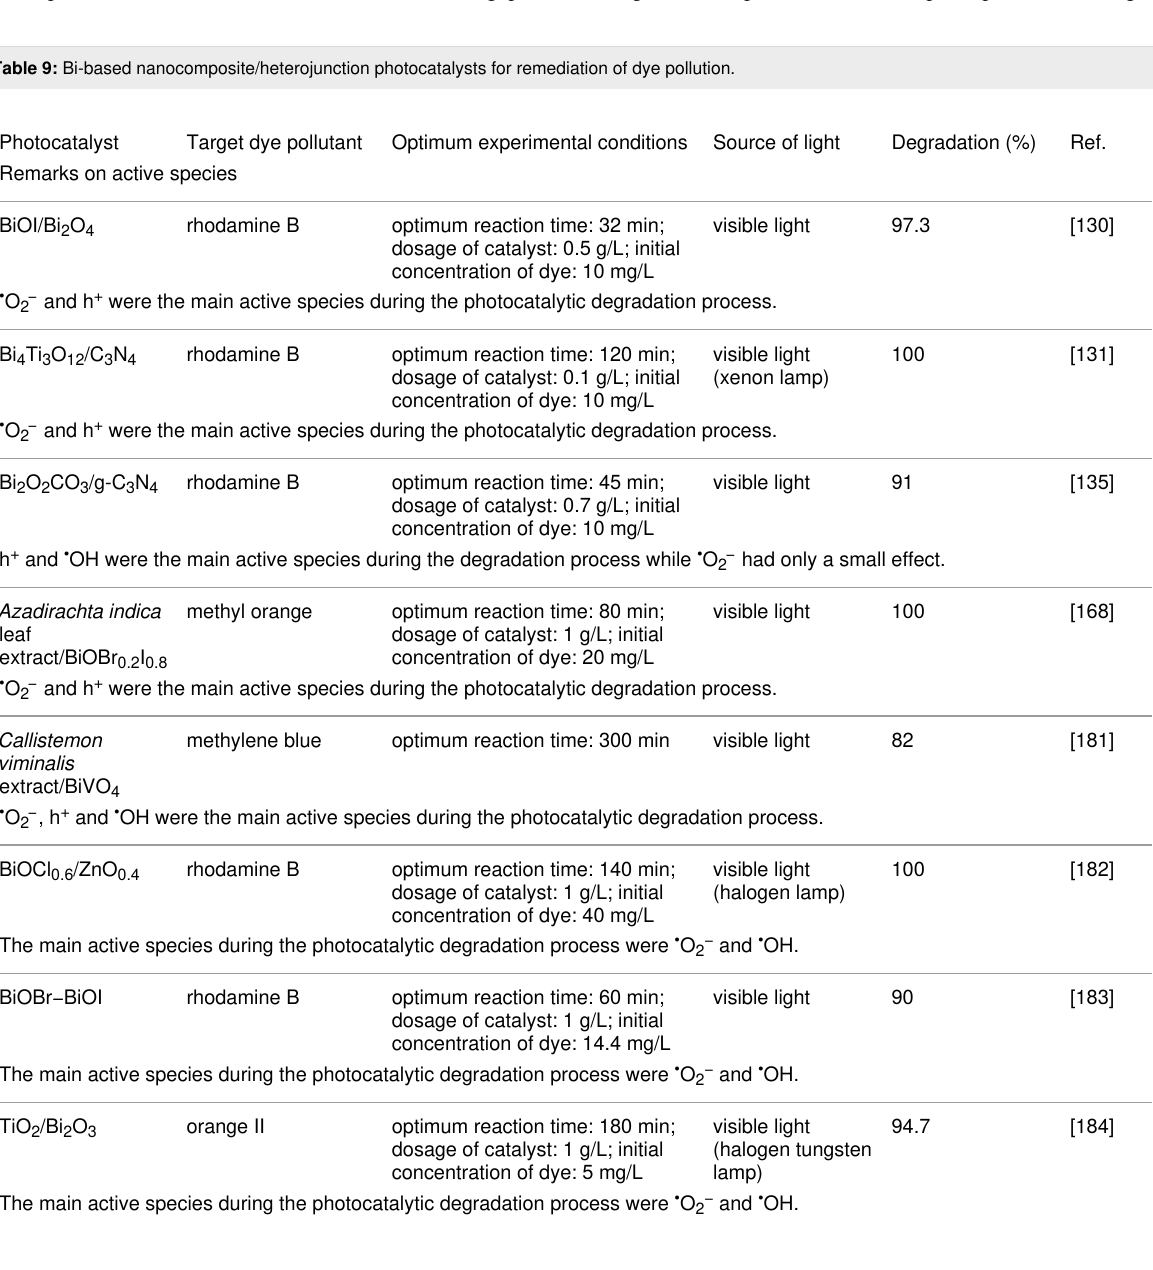
Table 9: Bi-based nanocomposite/heterojunction photocatalysts for remediation of dye pollution.